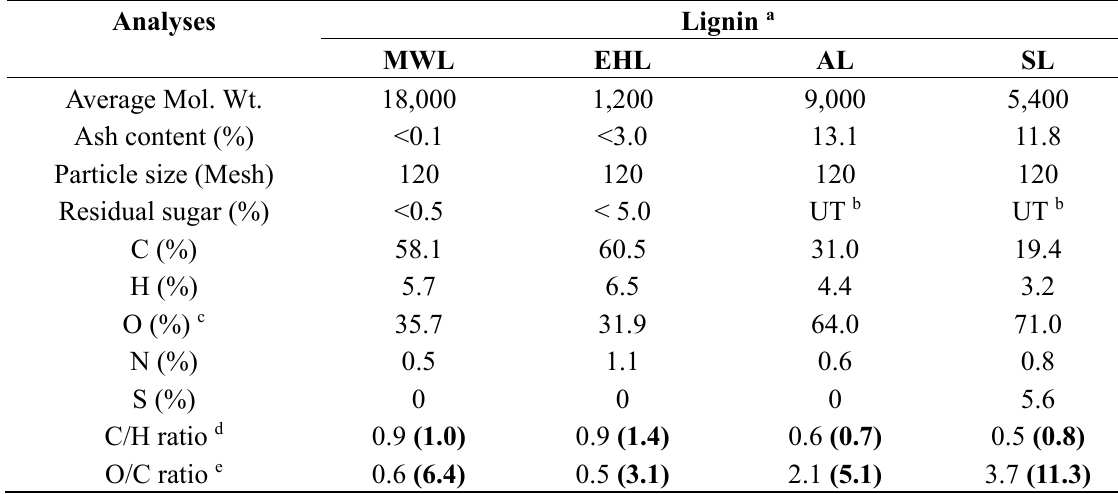
Table 4. Characterization of the four lignin types used for